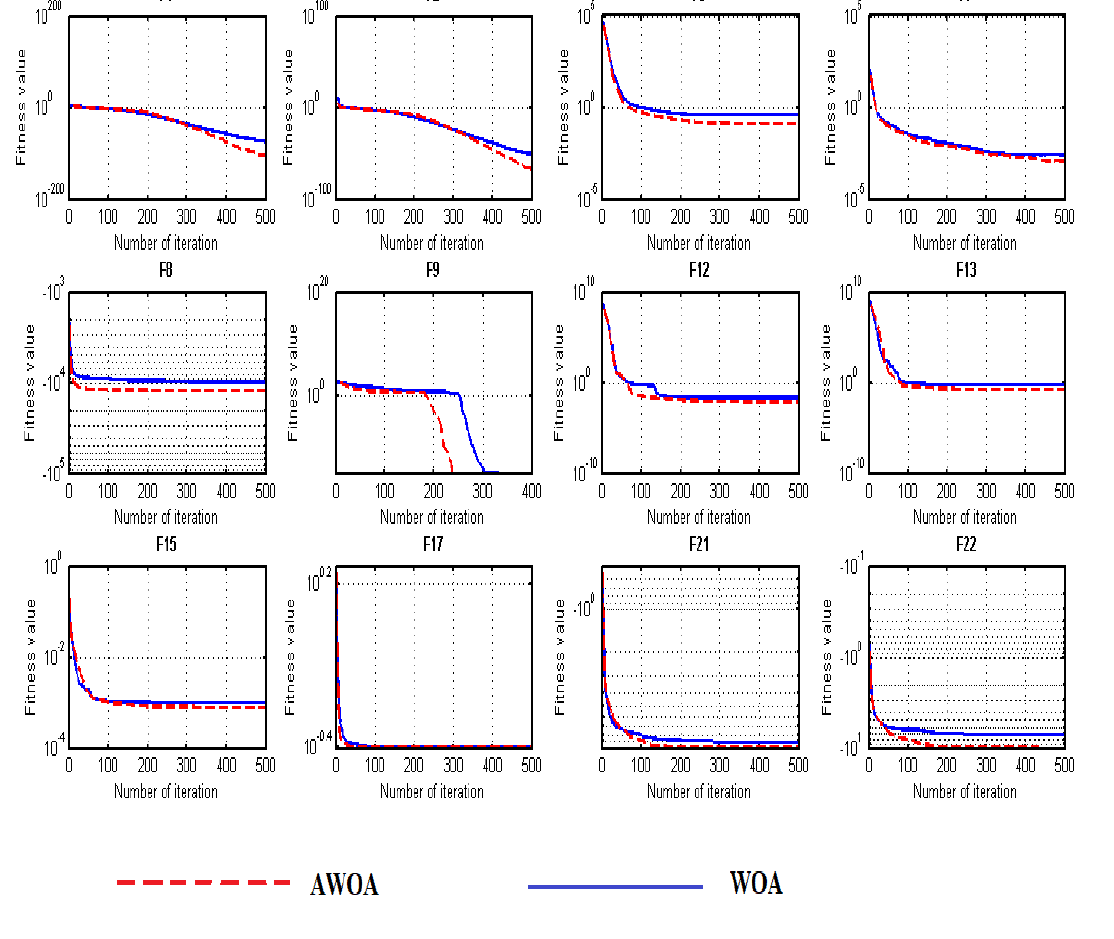
Figure 7. Convergence Behavior of AWOA and WOA.